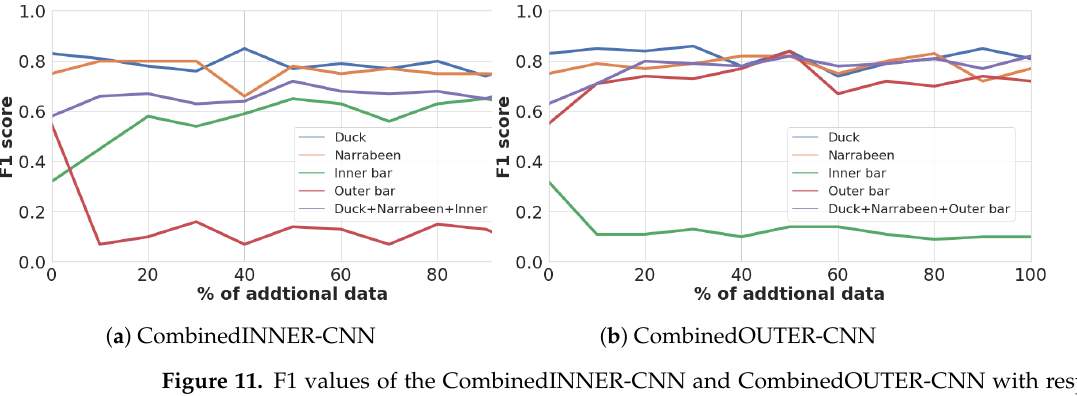
Figure 11. F1 values of the CombinedINNER-CNN and CombinedOUTER-CNN with respect to percentage of data coming from the Gold Coast with labels coming from ( a ) the inner bar or ( b ) the outer bar and added to the combined training dataset of Duck and Narrabeen.